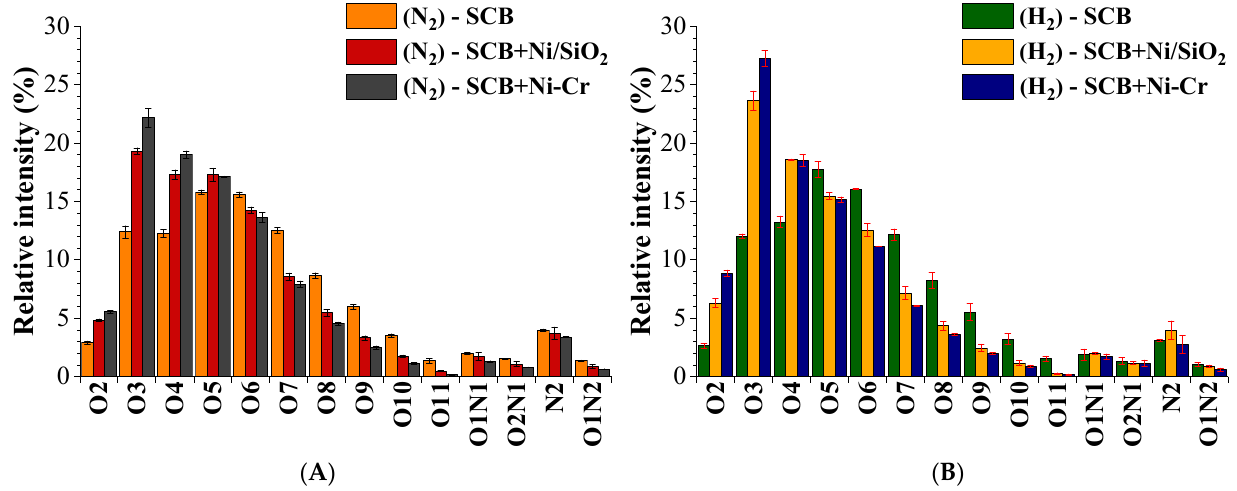
Figure 5. Histograms of classes of the LLFs produced by the processes in ( A ) inert atmosphere and ( B ) reactive atmosphere, analyzed by HESI(+)-FT-Orbitrap MS.